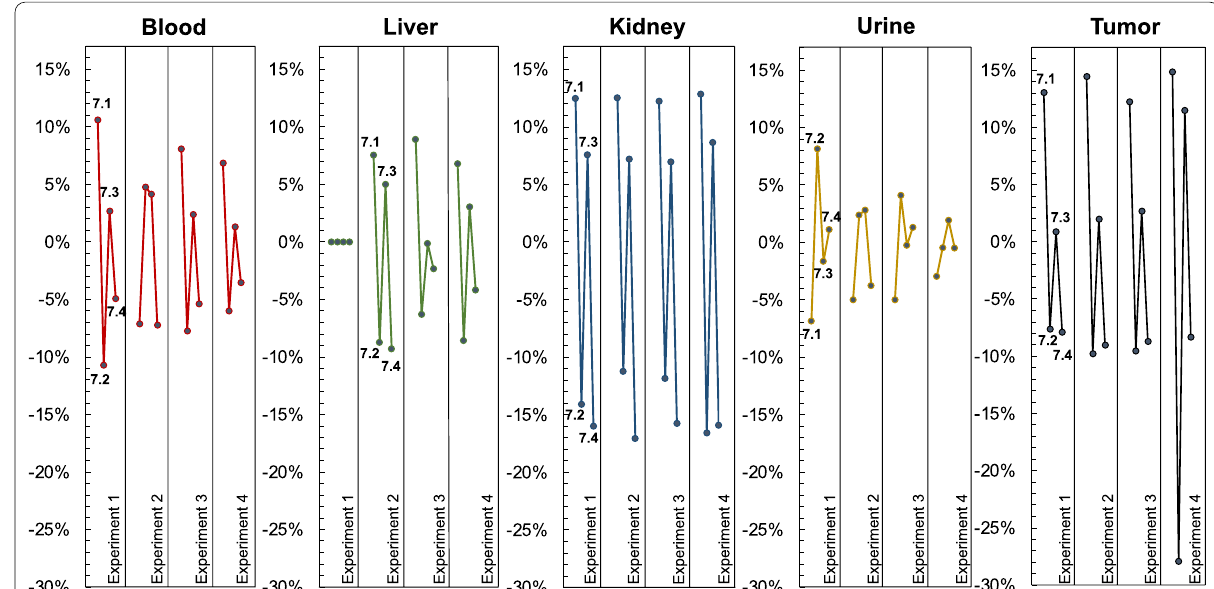
1) or a MM-400 Ball Mill (n 3). The percentage of activity after sample extraction and after = = SD). ±